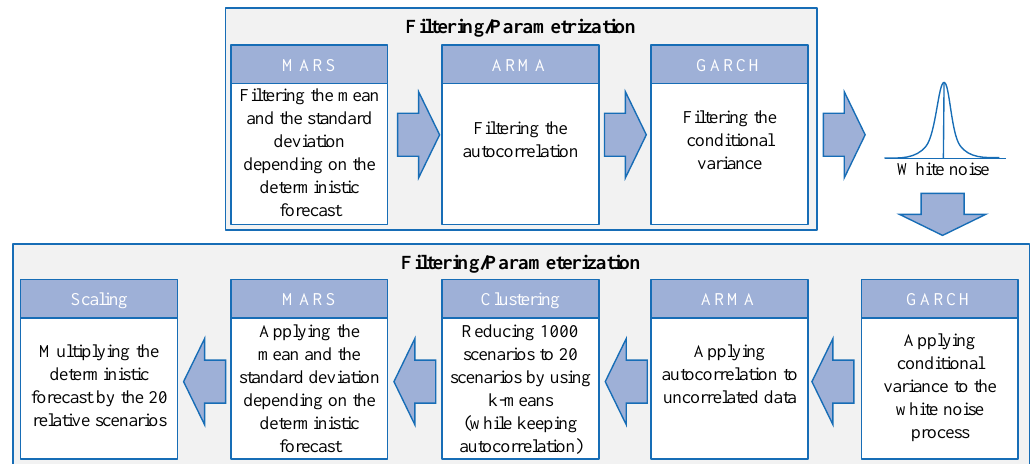
Figure 4. Process chain of the modeling process for forecasting errors, which is executed for wind, pv and